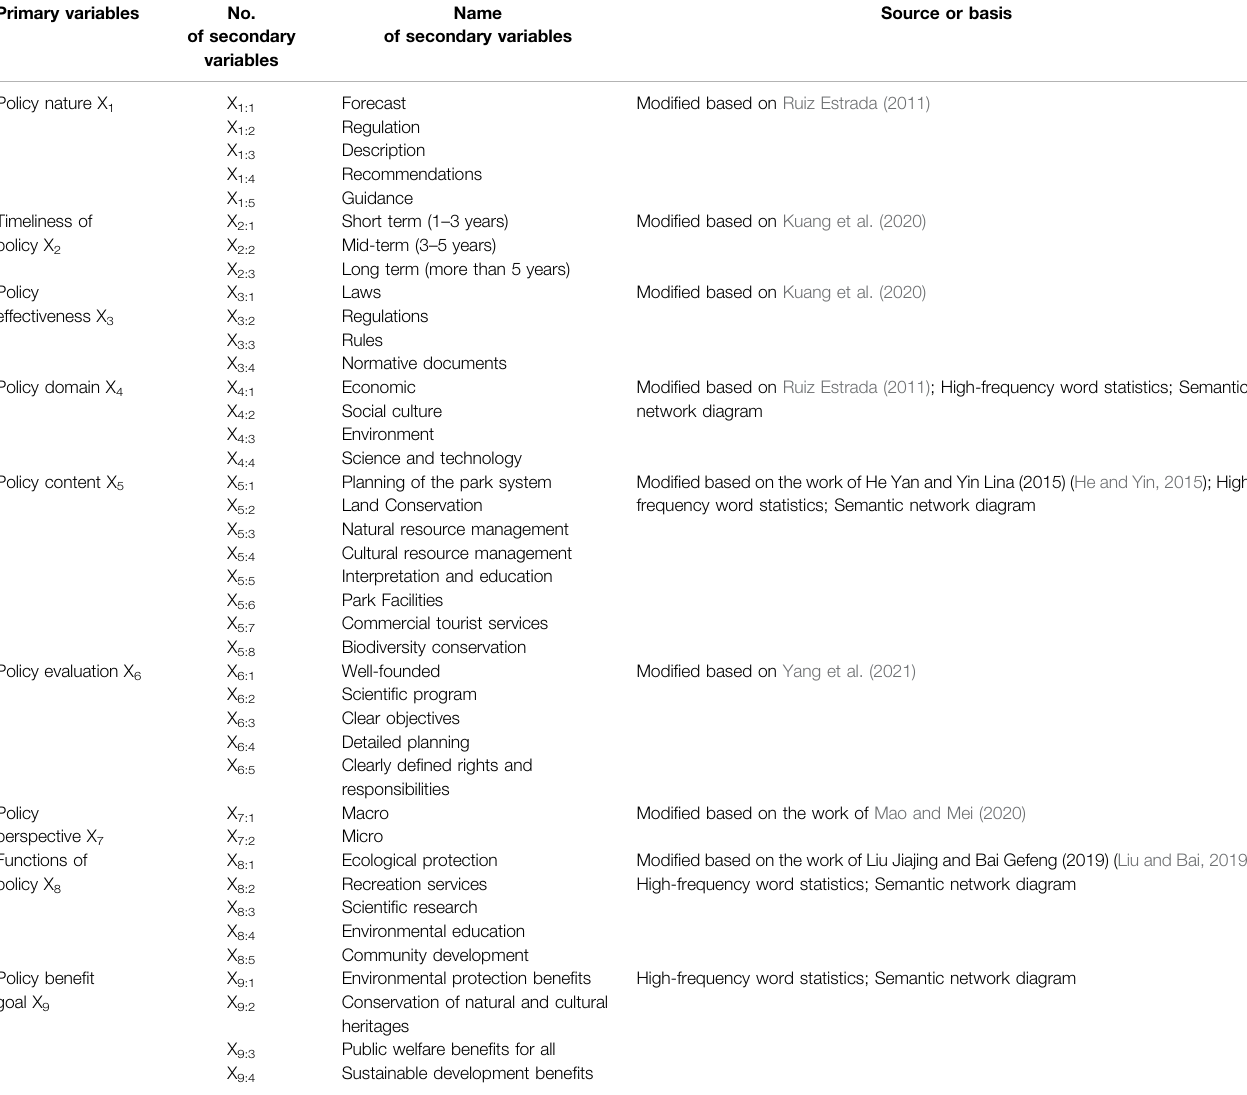
TABLE 3 | Variable settings of the quantitative evaluation system of national park policies.